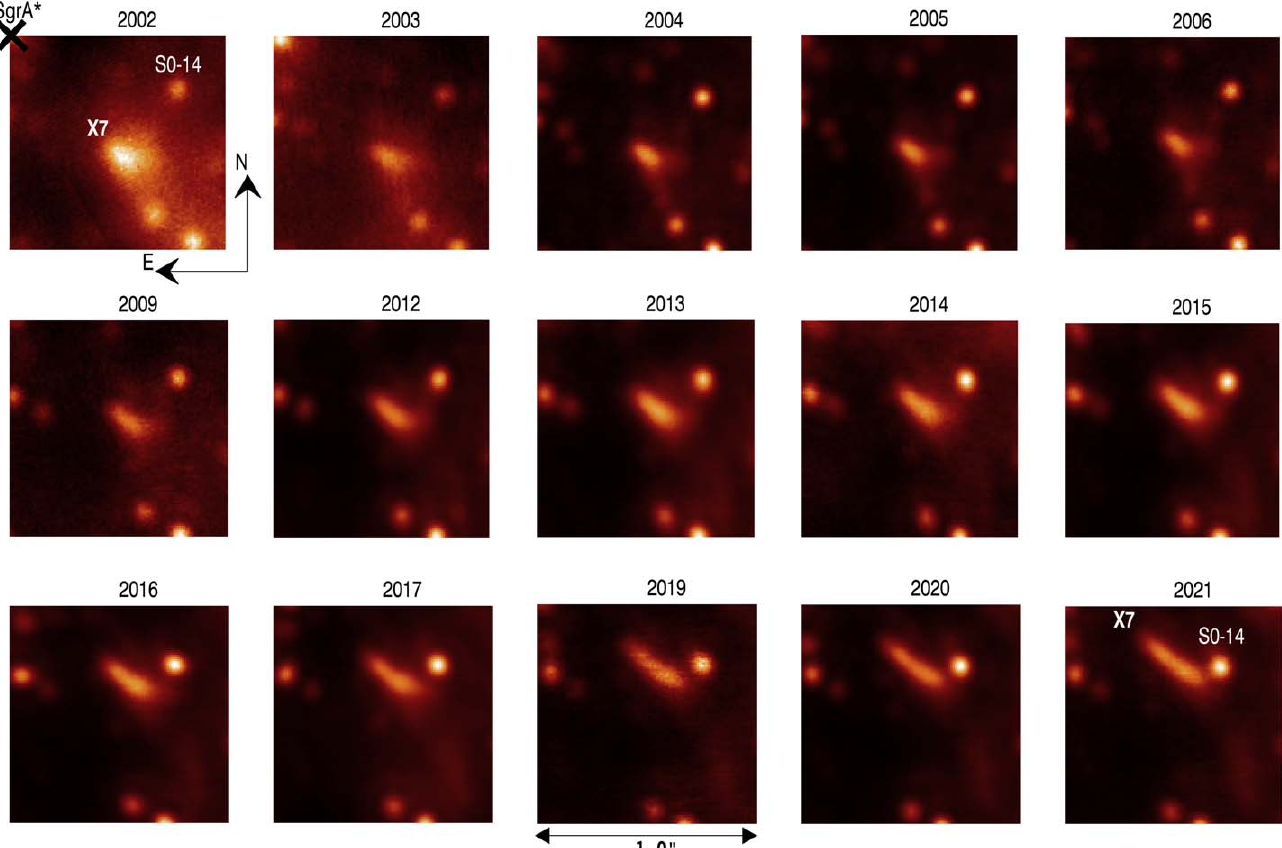
Figure 5. Morphology evolution of X7 ʼ s thermal dust emission. NIRC2 Lp band ( 3.8 μ m ) images between 2002 and 2021. The images are oriented with equatorial north at the top and with Sgr A * positioned in the upper left corner of each panel.